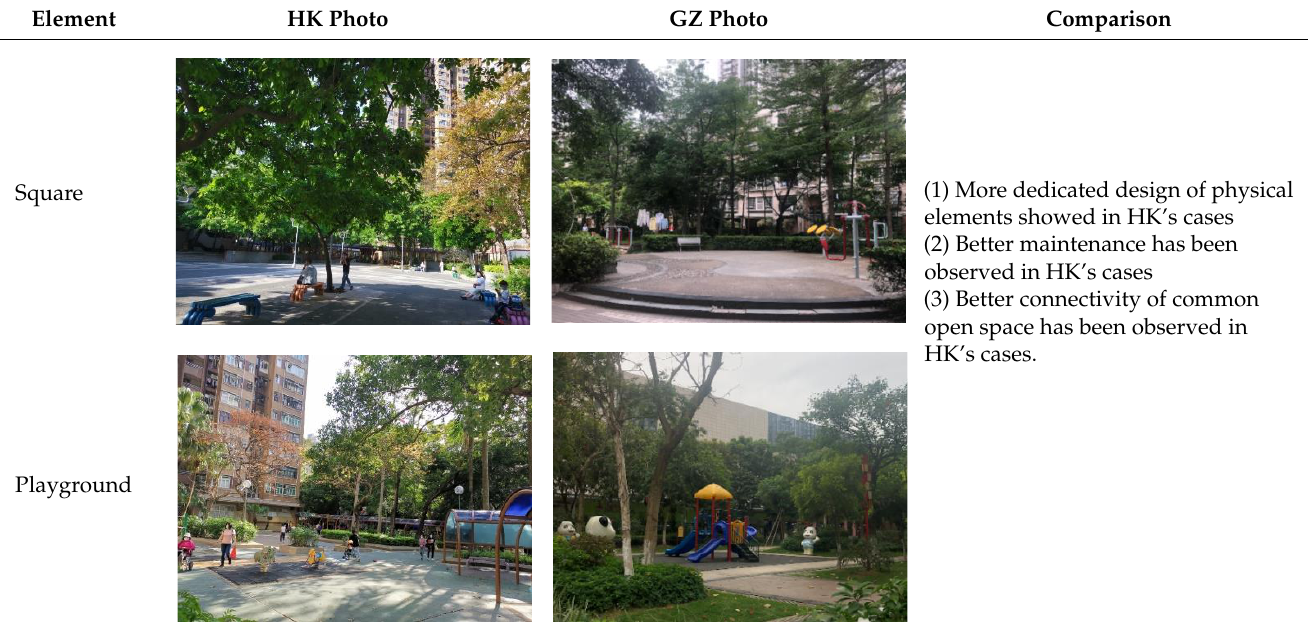
Table 6. Photo comparison of common open space between HK and GZ.